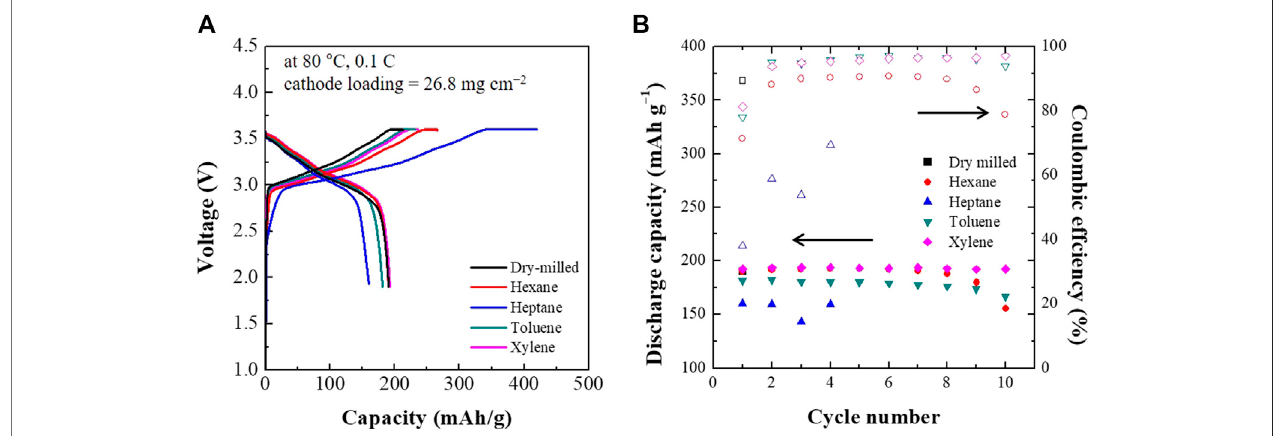
FIGURE 6 | The fi rst charge-discharge voltage pro fi les (A) and cycling performance (B) of ASSCs containing dry- and wet-milled Li 6 PS 5 Cl electrolytes.